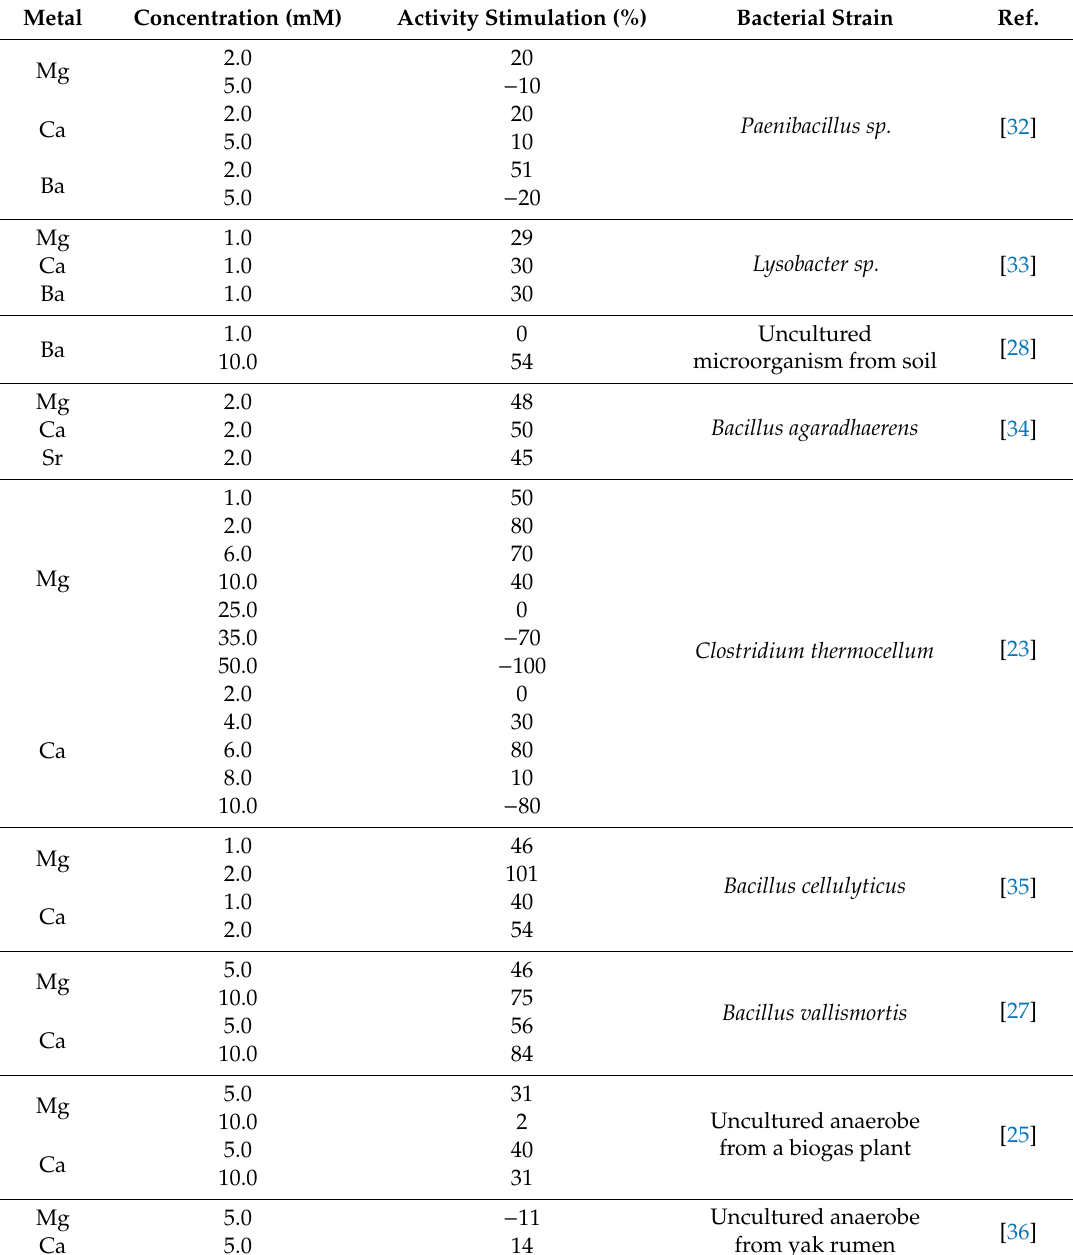
Table 1. E ff ect of alkaline earth metal ions over enzymatic activity of pure bacterial endoglucanases. Metal Concentration (mM) Activity Stimulation (%) Bacterial Strain Ref. 2.0 20 Paenibacillus sp.